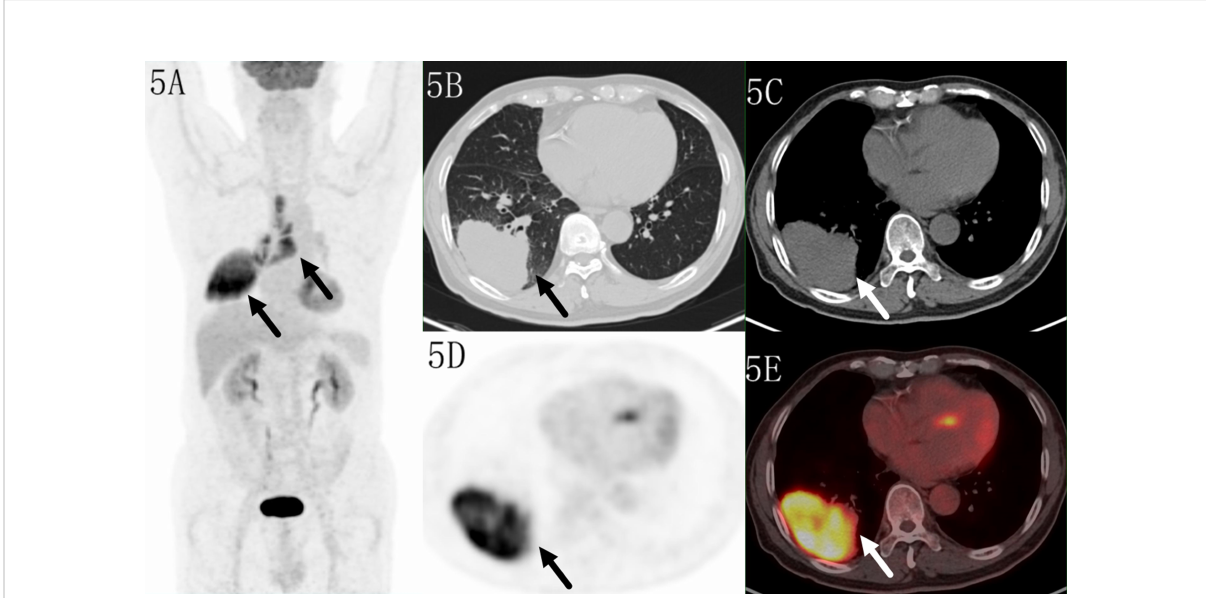
FIGURE 5 Images of a 70-year-old male patient with adenocarcinoma. PET MIP (A) showed a mass in the right lower lobe and multiple lymph nodes in the right hilar and mediastinum. The lesion located in subpleural site with a SUVmax of 14.4 on transaxialCT (B, C) , PET (D) and fused (E) images. Higher uptake was seen in the distal